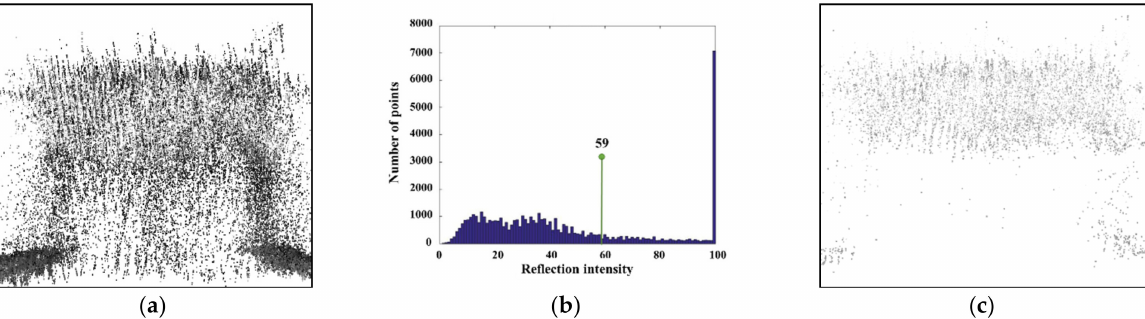
Figure 6. Point-cloud data segmentation by intensity inflection threshold: ( a ) reflection intensity value of point-cloud data, ( b ) histogram of reflection intensity distribution and ( c ) segmentation based on reflection intensity